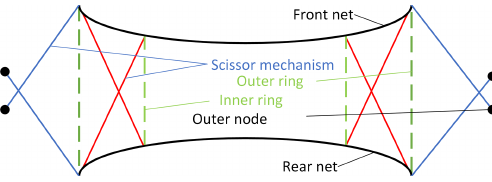
Figure 3. The schematic diagram of the front and rear net connec- tion.